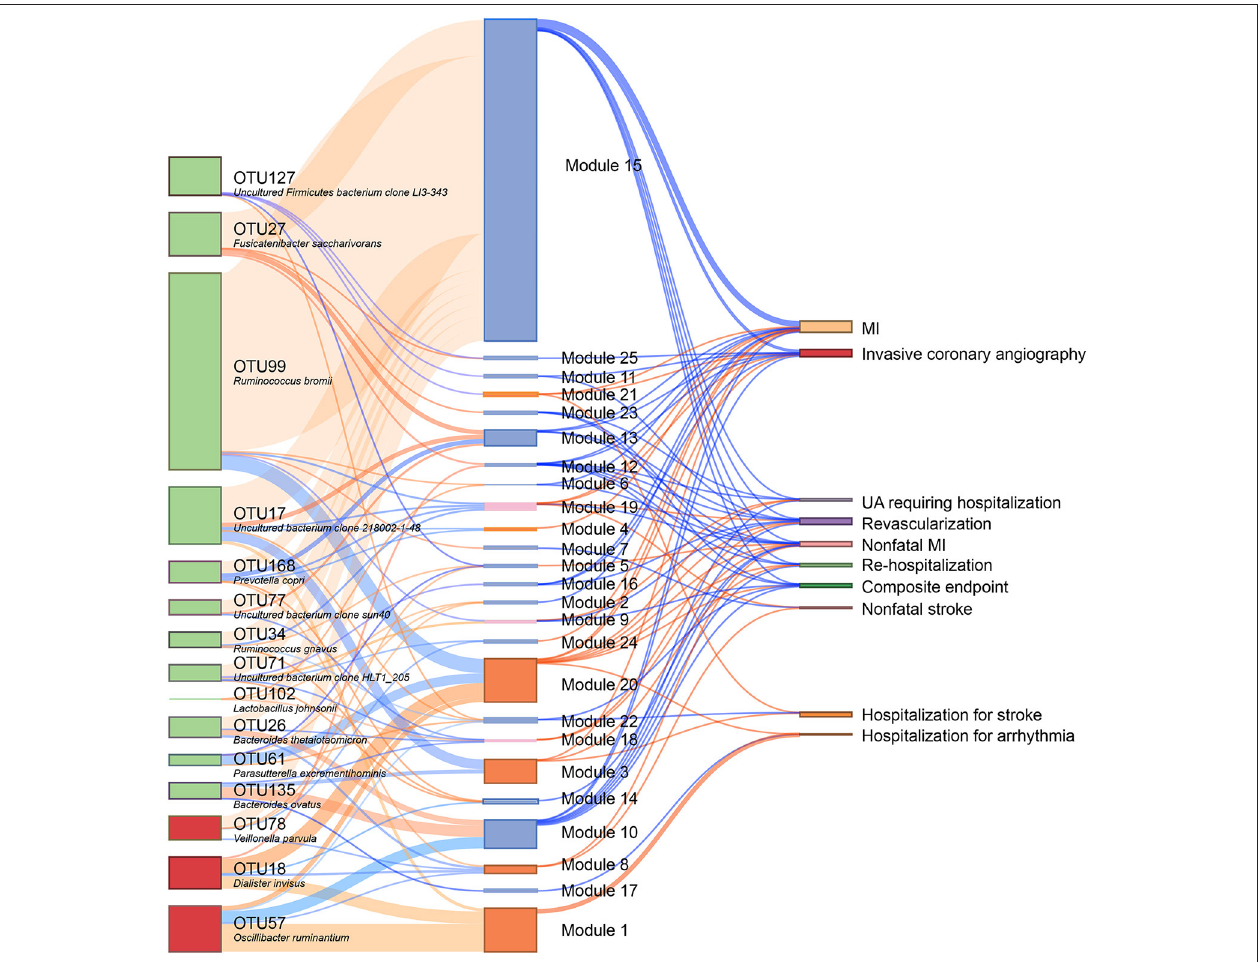
FIGURE 4 | Interrelationship between CHD-NAFLD-associated flora, serum metabolic features and clinical outcomes. Red connections indicate positive correlations, and blue connections indicate negative correlations (Spearman correlation analysis, P < 0.05). In the left first column, green boxes indicate CHD-NAFLD-negative OTUs, and red boxes indicate CHD-NAFLD-positive OTUs. In the middle column, light blue boxes indicate CHD-NAFLD-negative metabolic features, and orange boxes indicate CHD-NAFLD-positive metabolic features. A composite endpoint is defined as all-cause mortality and/or reoccurrence of ACS and/or readmission for cardiac